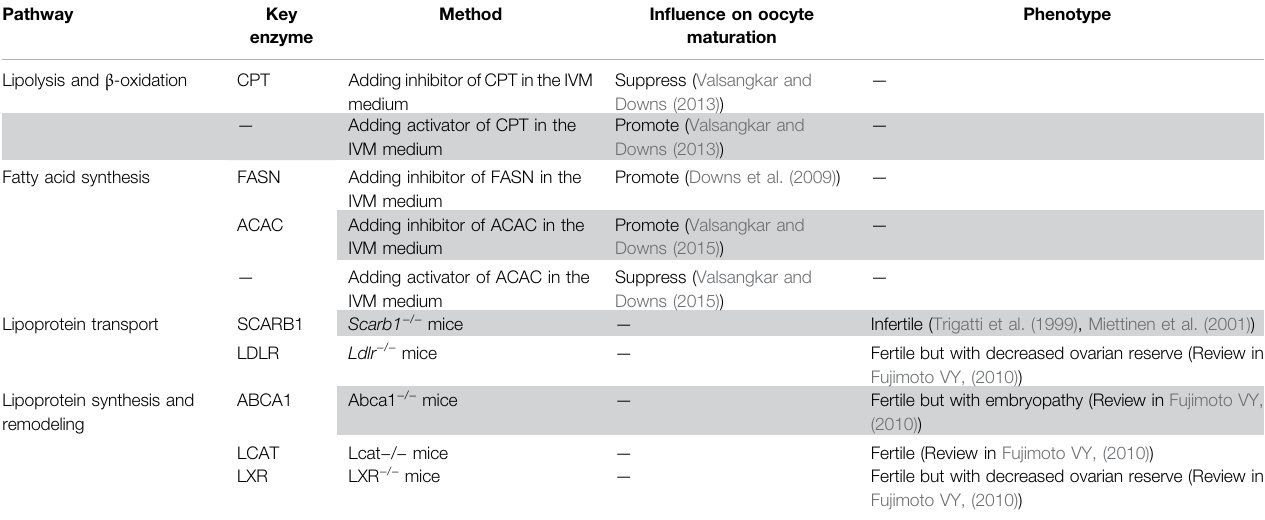
TABLE 1 | Summary of the association between lipid metabolism pathways and oocyte maturation or fertility. Pathway Key